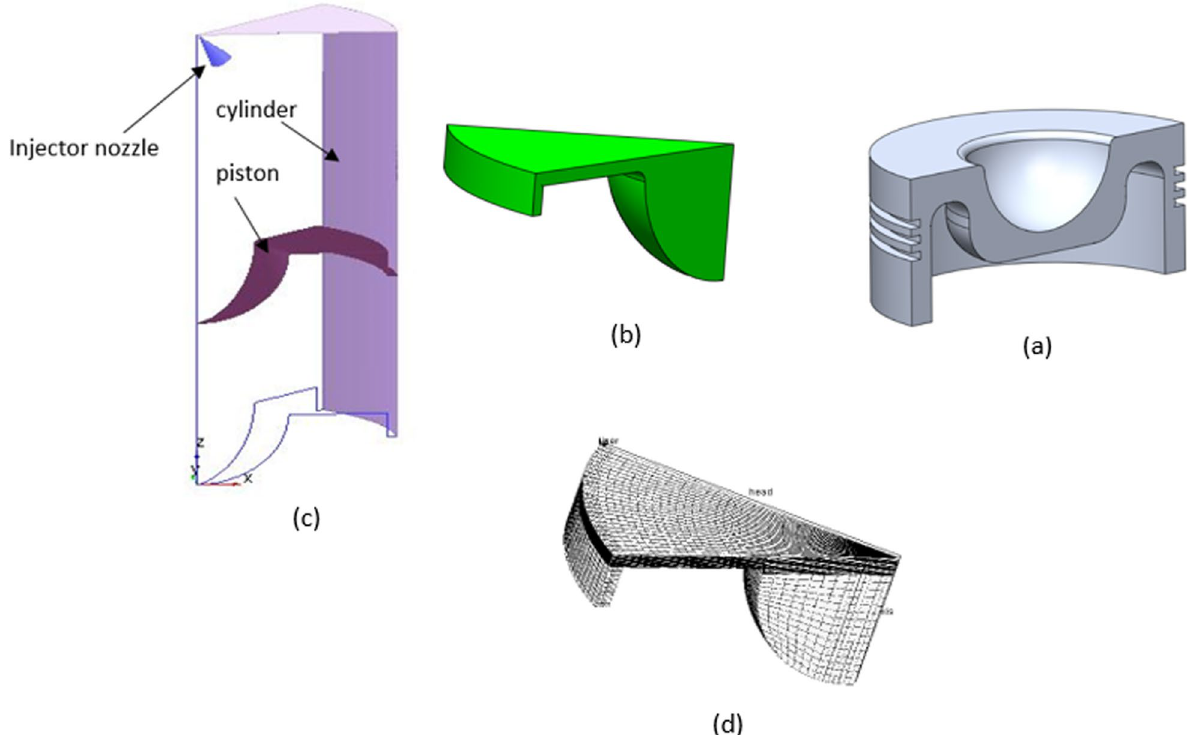
Fig. 2 geometry creating steps: a piston bowl, b computational sector, c piston sliding motion in the computational domain and d sector mesh